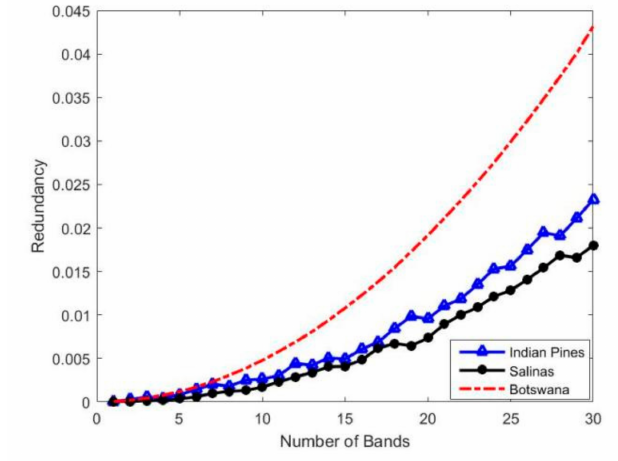
Figure 9. Information redundancy curves on different data sets.